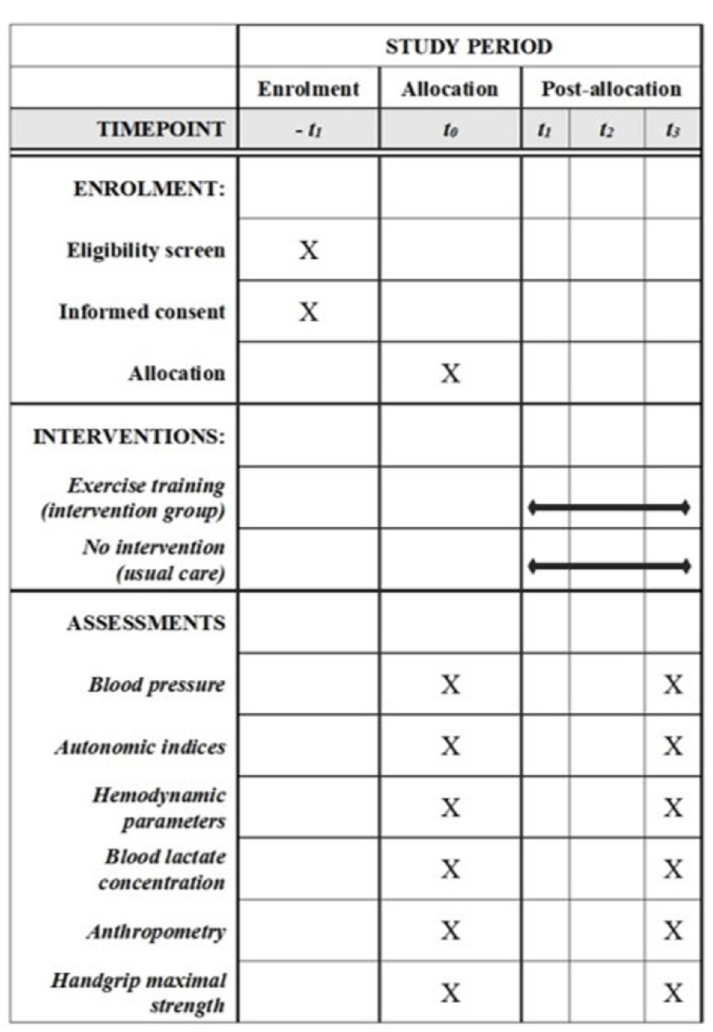
Fig 1. Schedule of enrolment, interventions, and assessments. - t 1 , enrolment week 0; t 0 , allocation and baseline week; t 3 , post-intervention (week